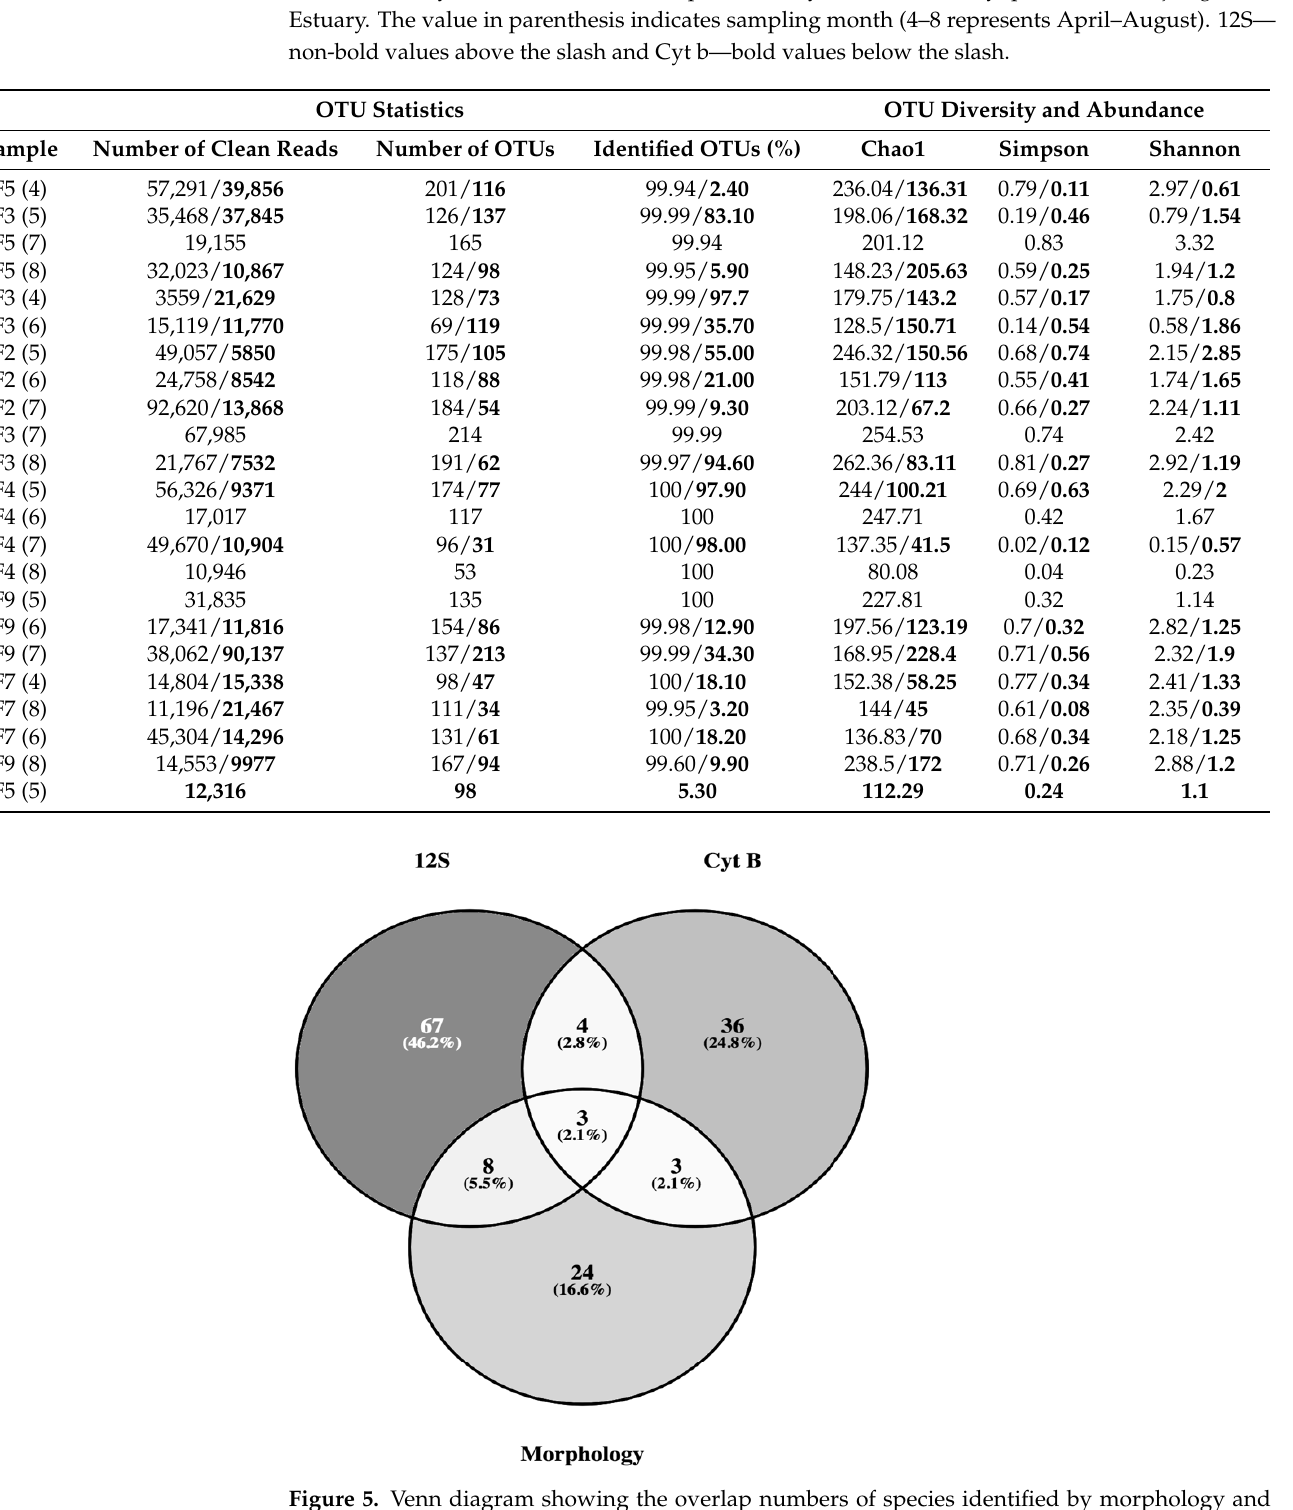
Figure 5. Venn diagram showing the overlap numbers of species identified by morphology and molecular tools in Oujiang River Estuary.